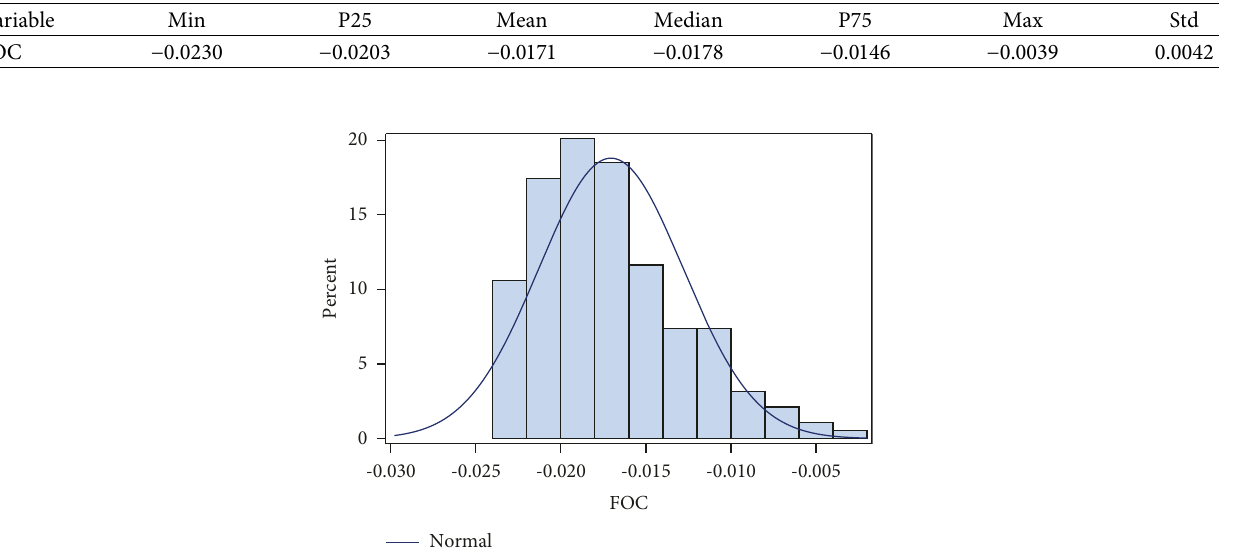
Table 7: Summary of the statistics of the first-order condition test.